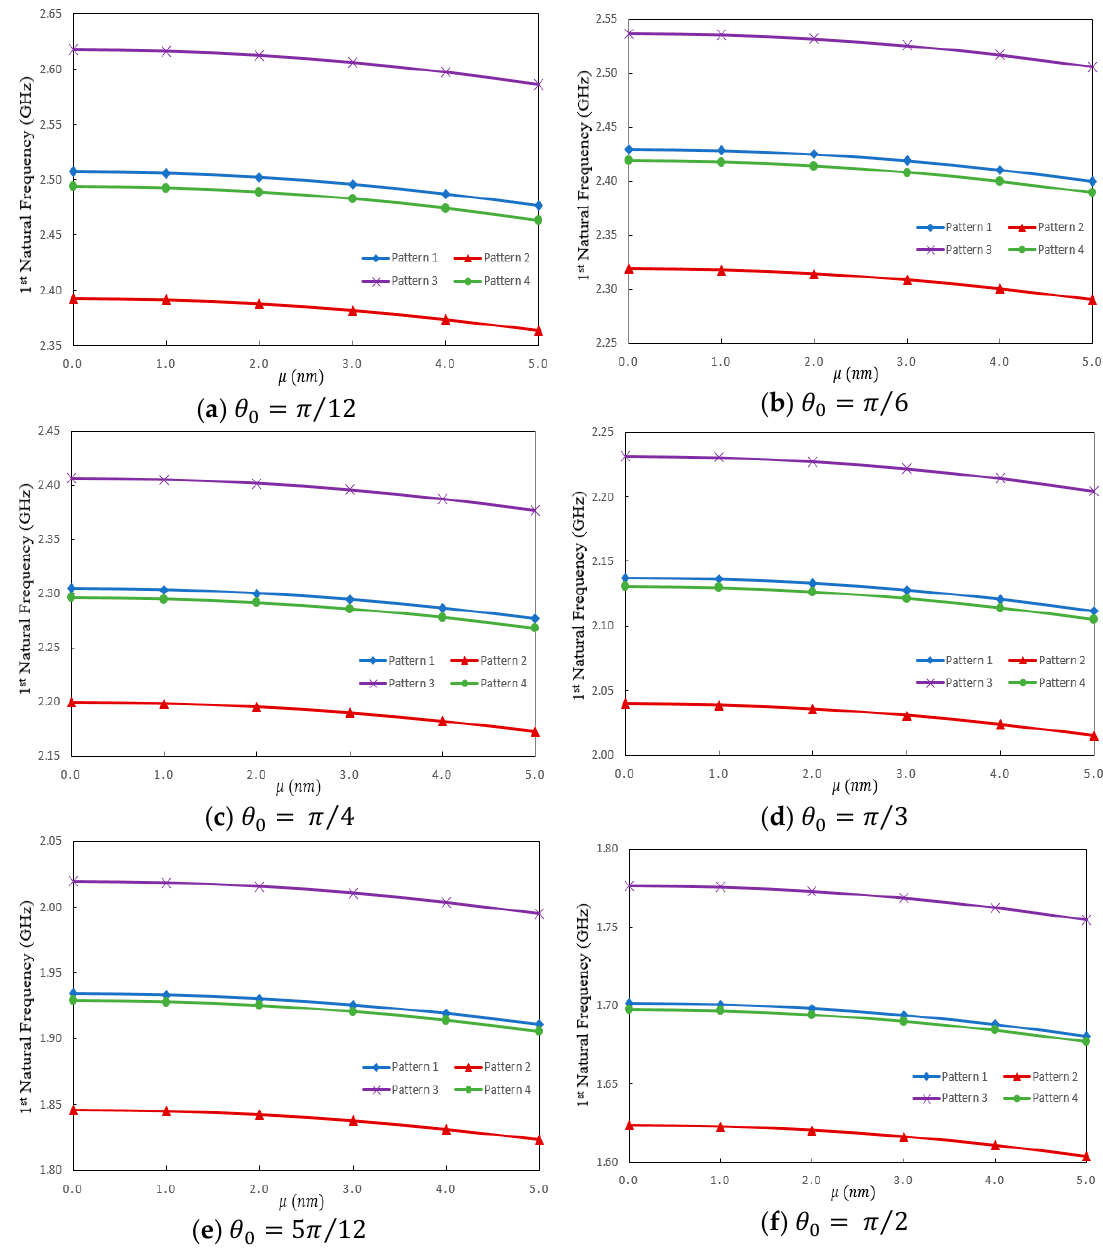
Figure 3. First natural frequency (GHz) of the composite curved nanobeam for different nonlocal parameters and reinforcement patterns; 𝑁 (cid:3013) (cid:3404) 12 , 𝑔 (cid:3008)(cid:3017)(cid:3013)∗ (cid:3404) 1 % , 𝑘 (cid:2869) (cid:3404) 𝑘 (cid:2870) (cid:3404) 0 . Results based on Patterns 1 and 4, instead, always fall within the lower ‐ bound and upper ‐